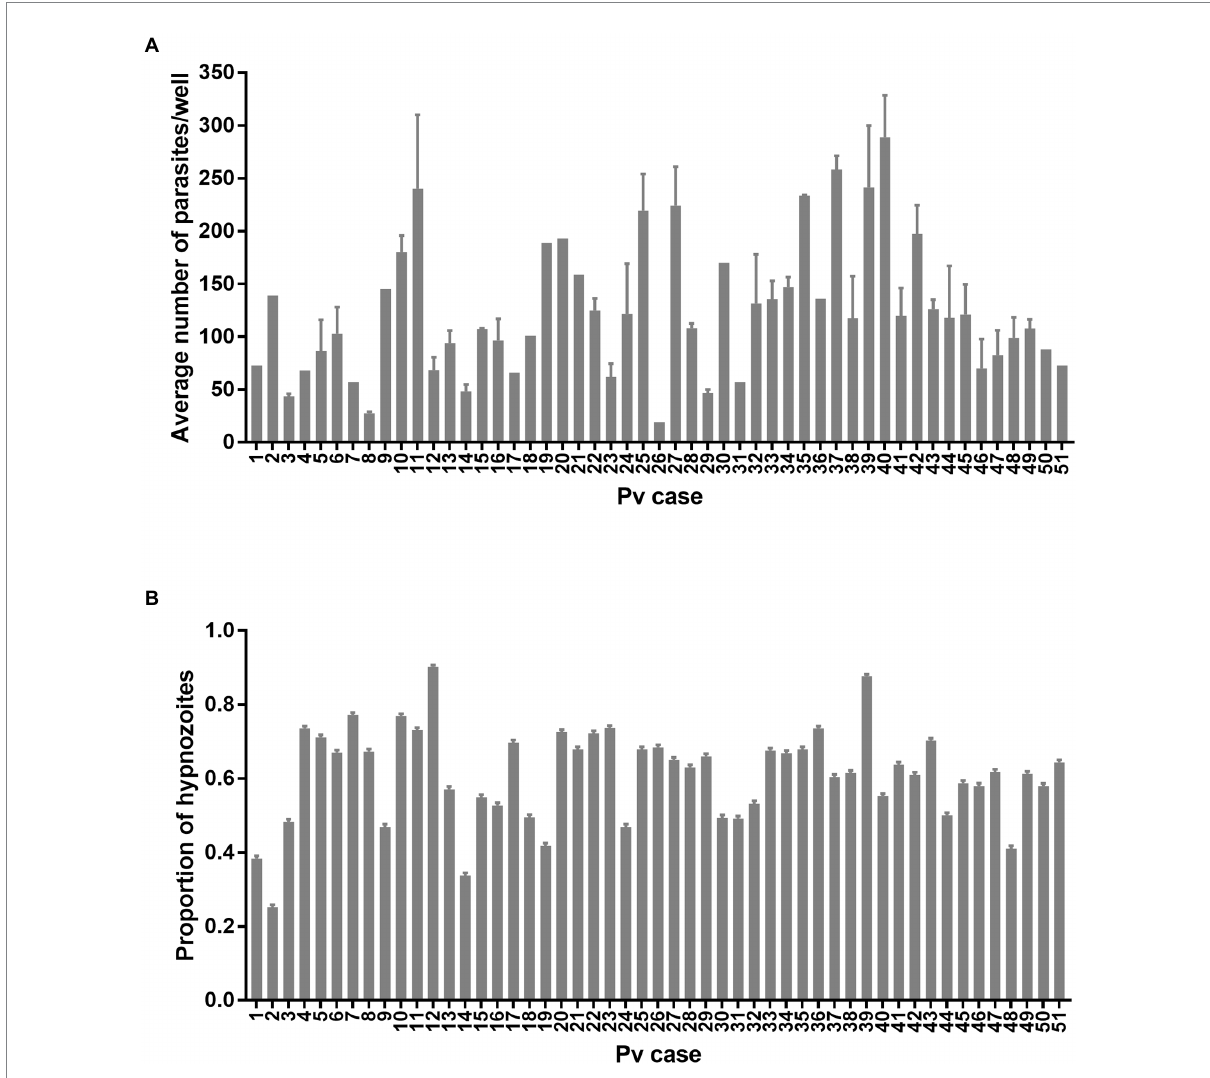
FIGURE 5 Growth metrics of P. vivax liver-stage parasites from 51 cases. (A) Average number of parasites per well and (B) proportion of hypnozoites from the 0.1% DMSO control wells of 132 assay plates initiated from 51 P. vivax cases for liver-stage drug discovery and development. Bars represent ±SE (A) or ±95% CI (B)